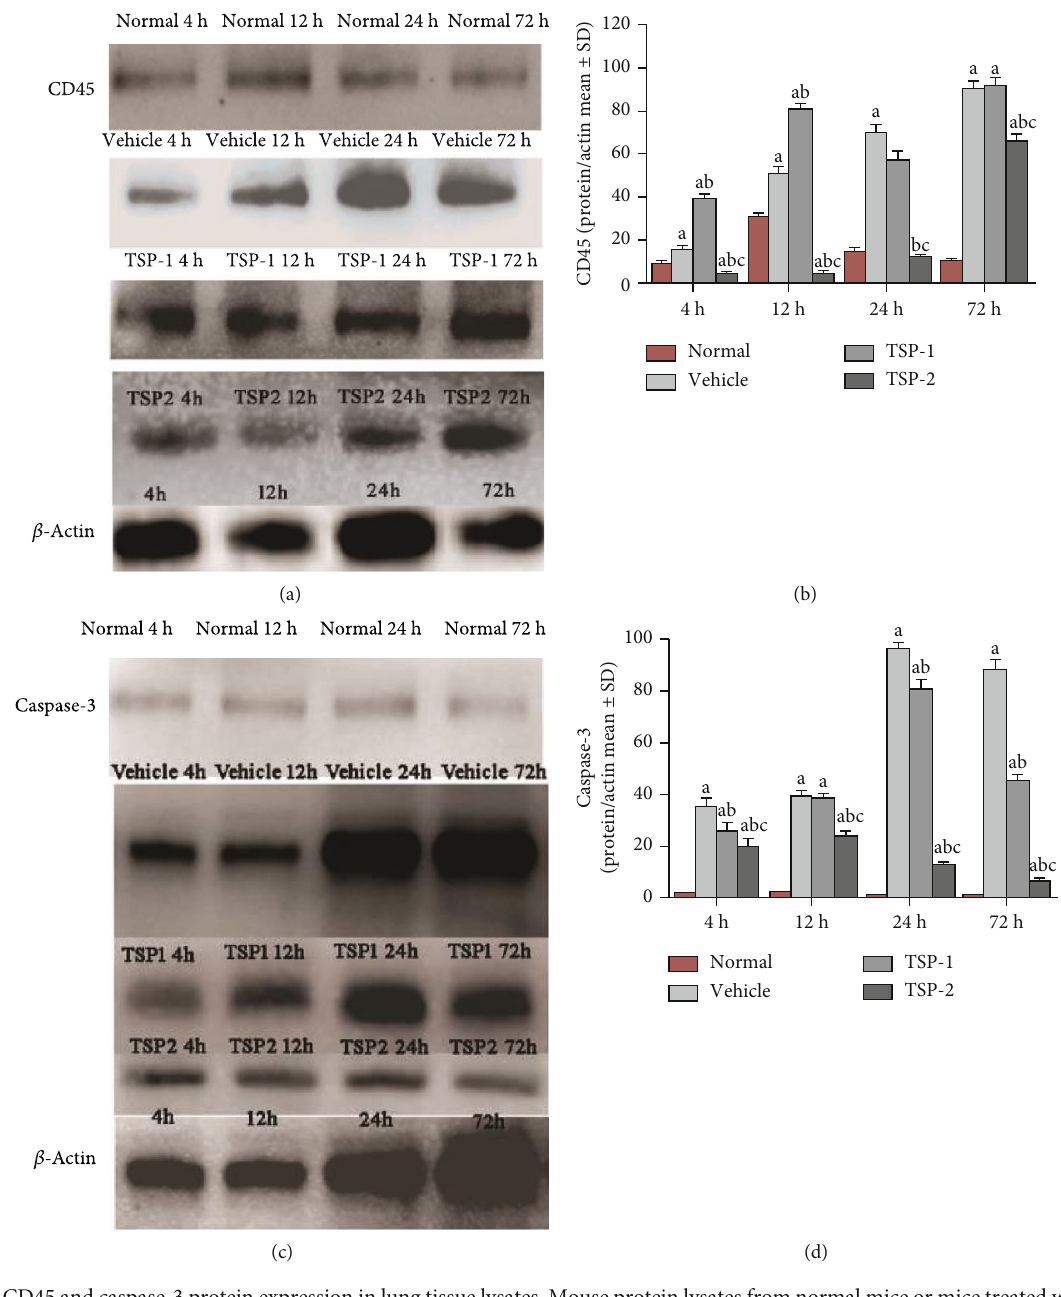
Figure 6: CD45 and caspase-3 protein expression in lung tissue lysates. Mouse protein lysates from normal mice or mice treated with LPS for 4, 12, 24, and 72h and overexpressing either empty vector (vehicle group), TSP-1 (TSP-1 group), or TSP-2 (TSP-2 group) were analyzed for CD45 (a) and caspase-3 (c) protein expression using Western blot analysis. β -Actin expression served as the loading control. (b, d) Bar graphs representing CD45 and caspase-3 expression after normalizing to β -actin expression among four di ff erent groups. The percentage of detected protein/actin is shown as mean ± SD . P value of < 0.05 depicts signi fi cant di ff erence. a P < 0 : 05 compared with normal control; b P < 0 : 05 compared with vehicle group; c P < 0 : 05 compared with TSP-1 transfected group ( n = 4 per